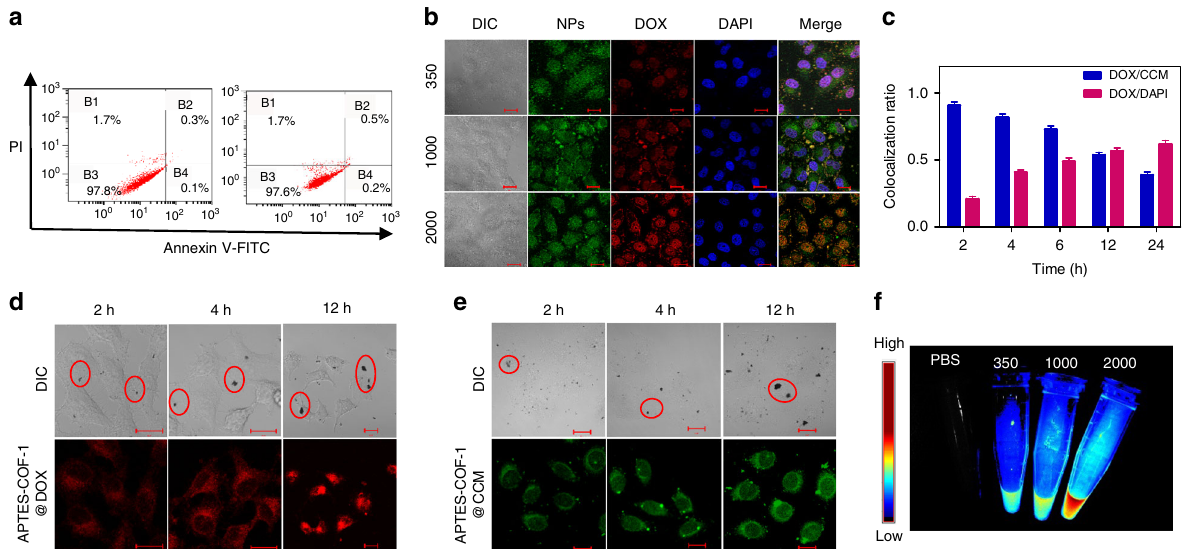
Fig. 4 In vitro cytotoxicity and cellular uptake. a Flow cytometry analysis of HeLa cells incubated with blank (left) and APTES-COF-1 (right). The four areas represent the different phases of the cells: necrotic (B1), late-stage apoptotic (B2), early apoptotic (B4), and live (B3). b Confocal images of HeLa cells recorded at 6 h after co-incubation with the three different DOX (red channel)-loaded PEG-CCM@APTES-COF-1 nanoparticles (NPs) (green channel). c Co-localization ratio analysis on HeLa cells between the red channel from DOX and green channel from CCM and that between the red channel from DOX and the blue channel from the stained nuclei. Each data point represents the average and SD (one above and one below for the error bars), as measured from fi ve different analysis in a single experiment. d Confocal images of HeLa cells after treatment with DOX-loaded APTES-COF-1 at different times corresponding to in vivo release. The inset shows the corresponding large APTES-COF-1 aggregates of the area within the dotted circle on the cell surface. e Confocal images of HeLa cells after treatment with CCM-loaded APTES-COF-1 at different times corresponding to in vivo release. The inset shows the corresponding large APTES-COF-1 aggregates of the area on the cell surface. The blue channel was excited at 405 nm and collected between 450 and 500 nm; the green channel was excited at 488 nm and collected between 510 and 550nm; the red channel was excited at 543 nm and collected between 590 and 650 nm. The scale bars are 20 μ m. f Luminescent image of the CCM after addition of sample to the